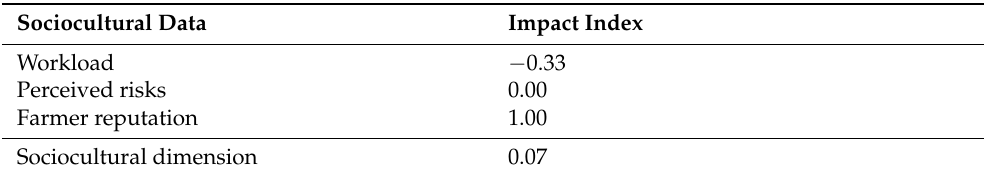
Table 6. Assessment of the changes of the sociocultural dimension with cover crops as soil improving cropping system. The Impact index was calculated using the responses of practitioners in structured interviews at the study region in Germany.